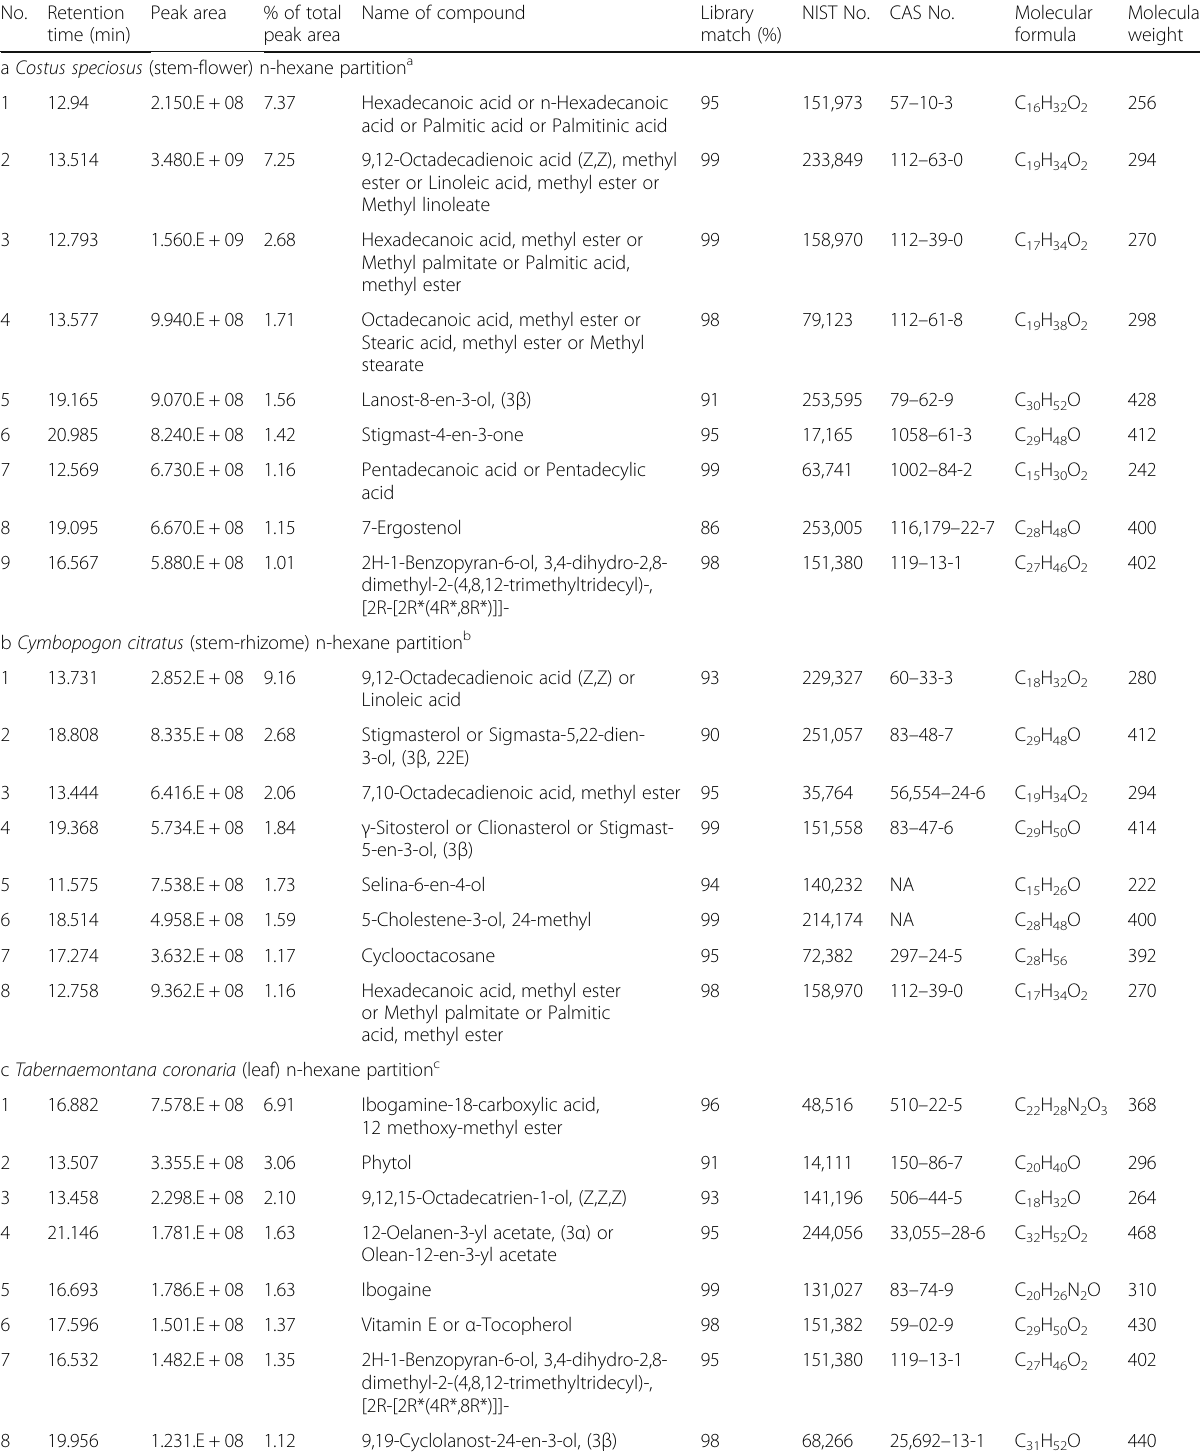
Table 2 a-c Major phytochemical compounds identified in the active plant n-hexane partitions by gas chromatography-mass spectrometry chemometric profiling No. Retention Peak area % of total Name of compound Library time (min) peak area